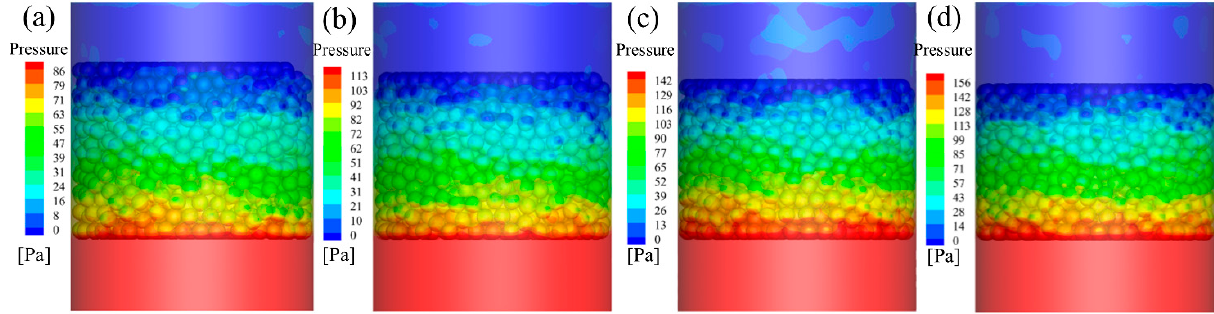
Figure 12. The contours of pressure drop under different vertical pressures at inlet velocity V 0 = 0.6 m/s: ( a ) 0 kPa ( b ) 50 kPa ( c ) 150 kPa ( d ) 250